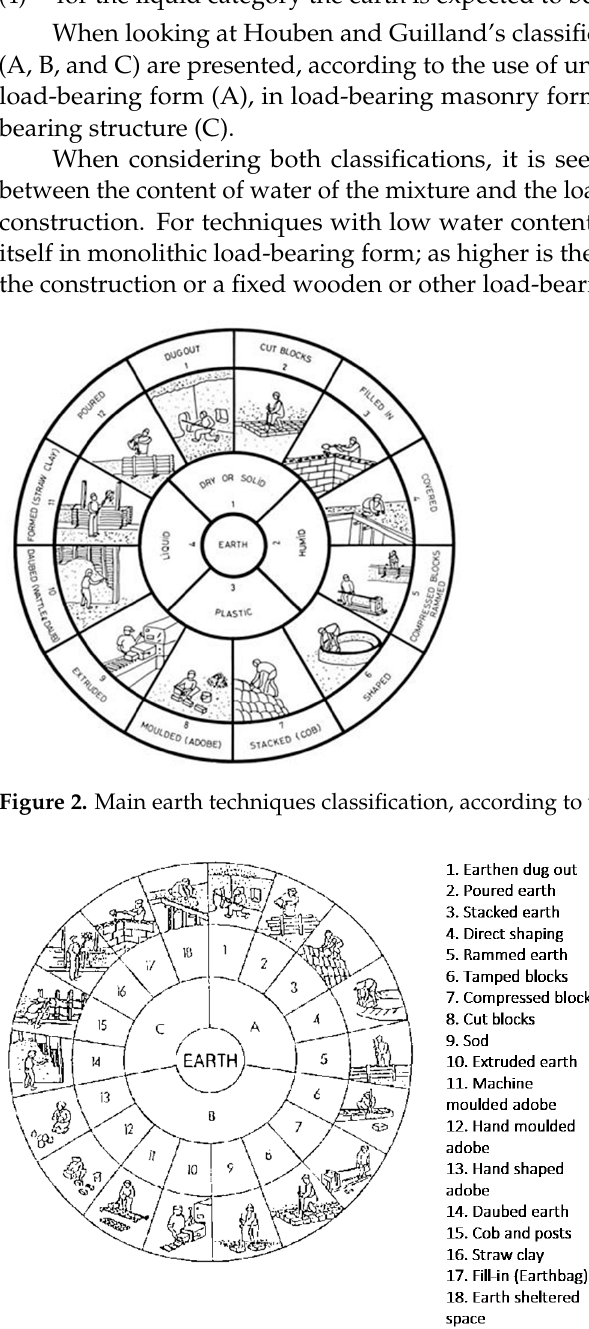
Figure 3. Main earth techniques classification, according to the load bearing system